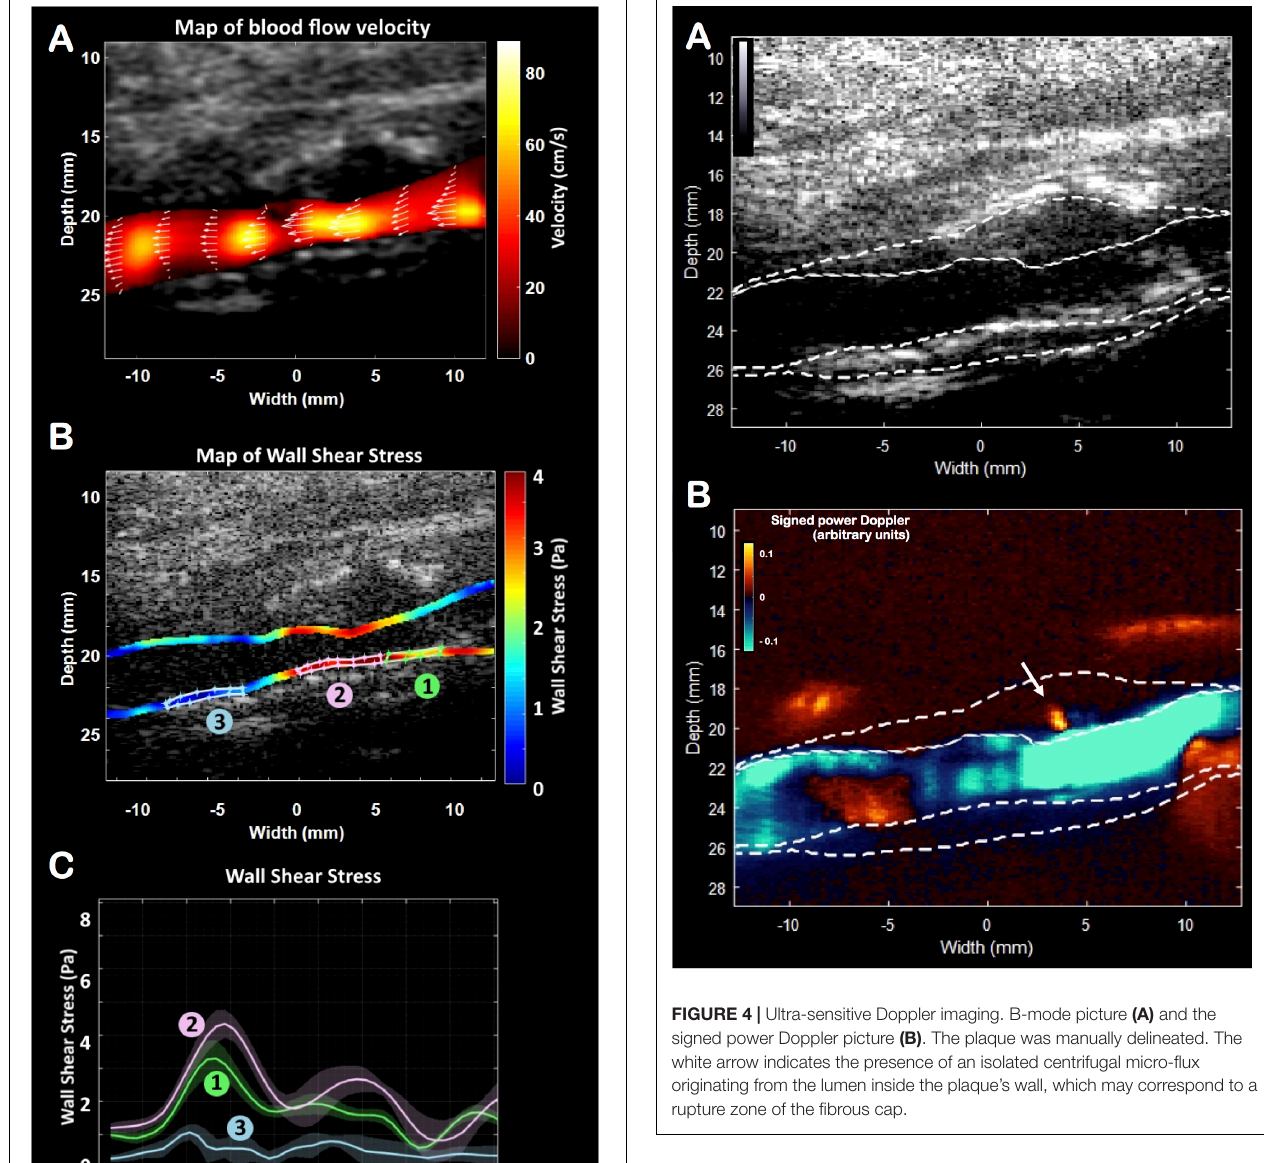
dropped below 1.45 Pa at the plaque descent ( Figure 3 and Supplementary Video S1 ).